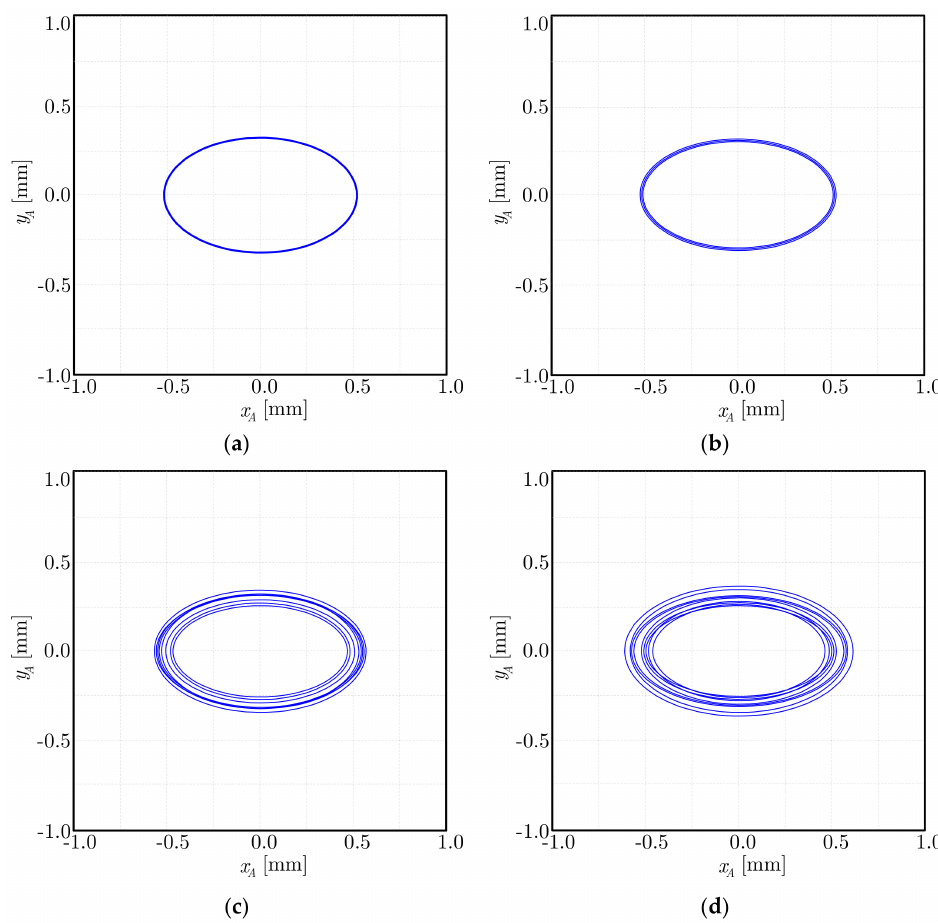
Figure 5. The orbit motion under the ideal and three other randomly uncertain states, where ( a ) is the ideal results and ( b – d ) are the results with δ R = 0.02, 0.08, and 0.20,